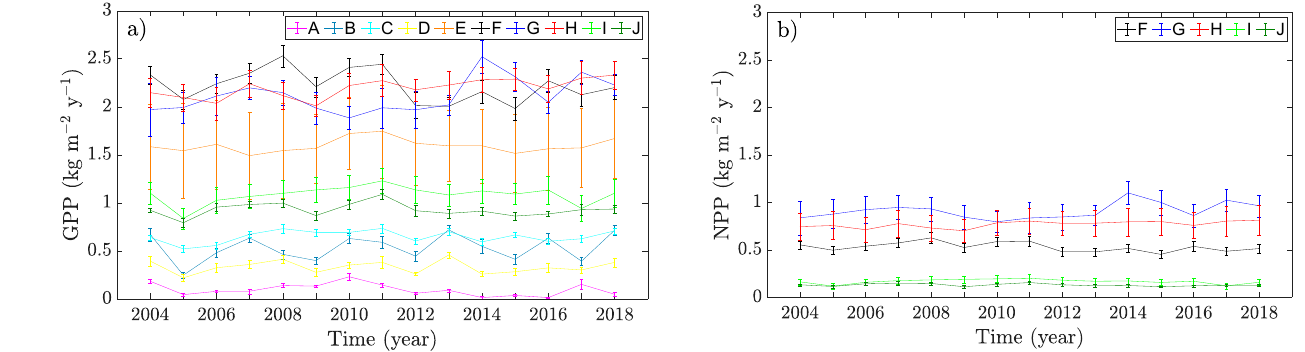
Figure 4. Annual GPP ( a ) for all sites and NPP ( b ) only for forest sites described in Table 1.